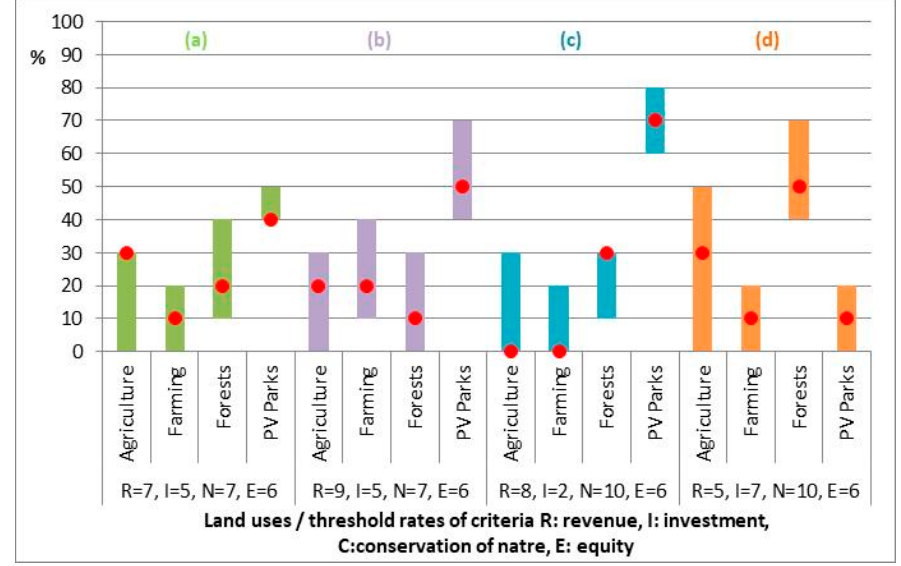
Figure 10. Ranges of land uses’ percentages for different sets of threshold values for the examined optimisation criteria.